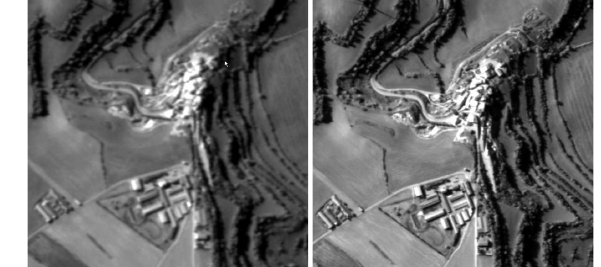
Figure 8. Resolution differences between Nadir image (left) and Backward/Forward images (right).